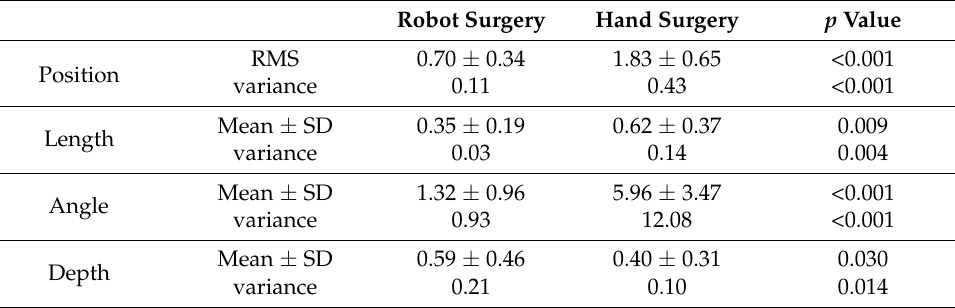
Table 4. Comparison of accuracy between robotic and manual surgeries for position, length, angle and depth